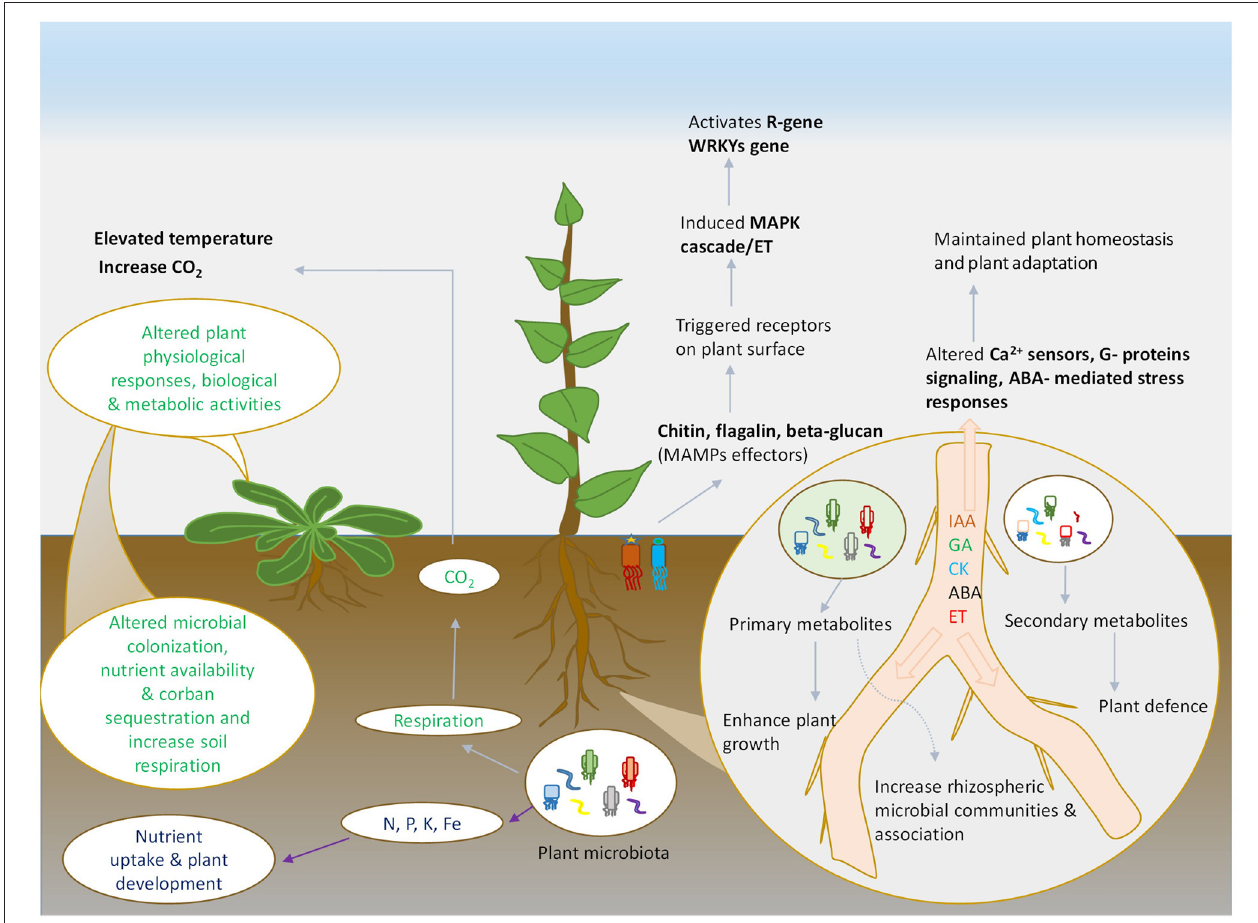
FIGURE 1 | Schematic representation of plant and microbes interaction. Various plant and microbes derived compounds that shape the microbial community and altered the plant immunity under environmental